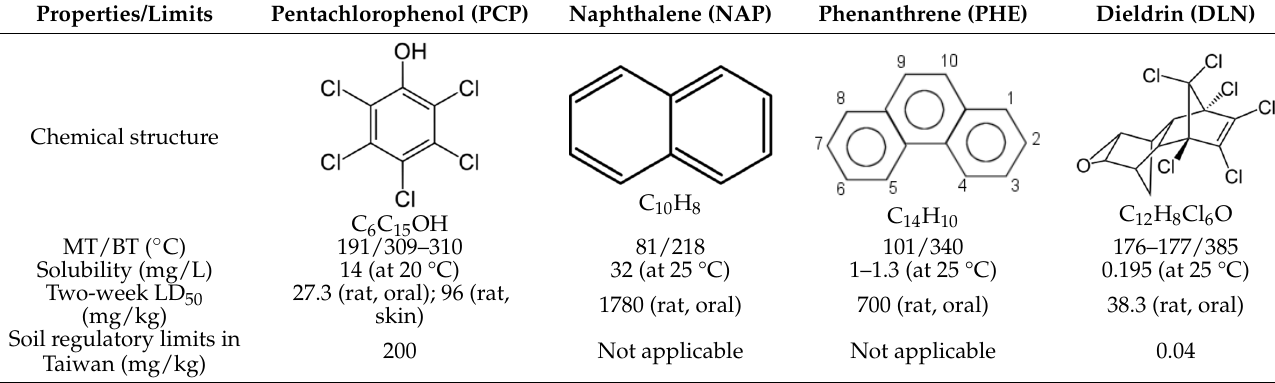
Table 1. Some properties and regulatory limits of the tested POPs, including PCP, NAP, PHE and DLN. Properties/Limits